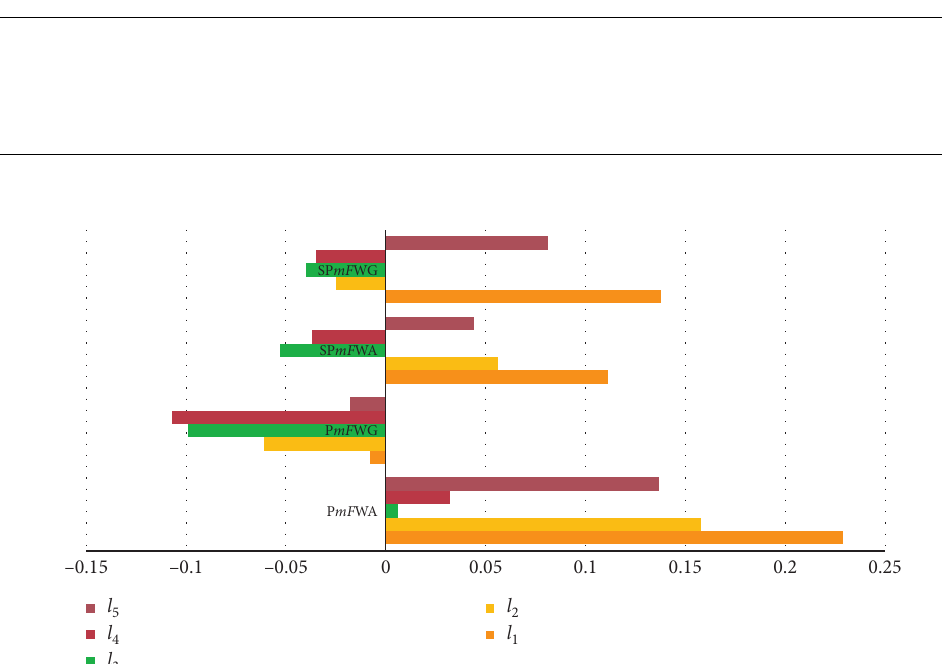
Figure 3: Horizontal bar chart of the two rankings.